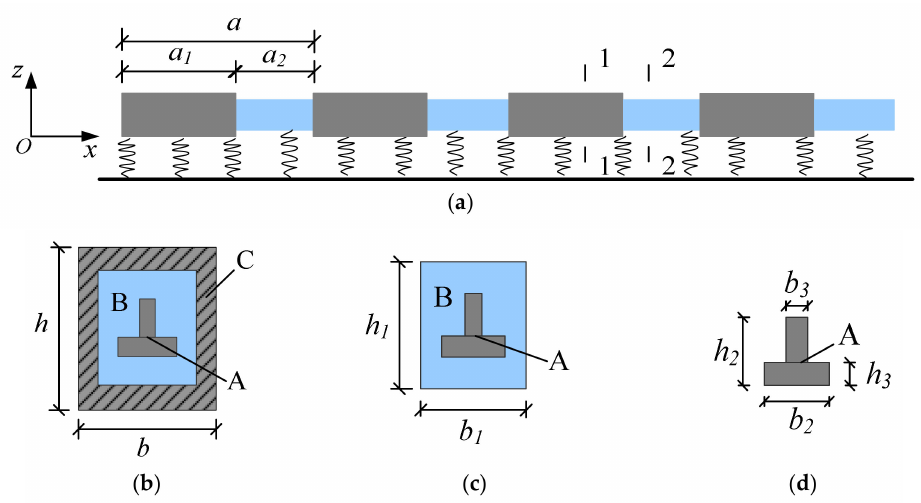
Figure 1. ( a ) Schematic diagram of periodic beam on elastic foundation; ( b ) 1-1 cross-section, ( c ) 2-2 cross-section; ( d ) cross-section of